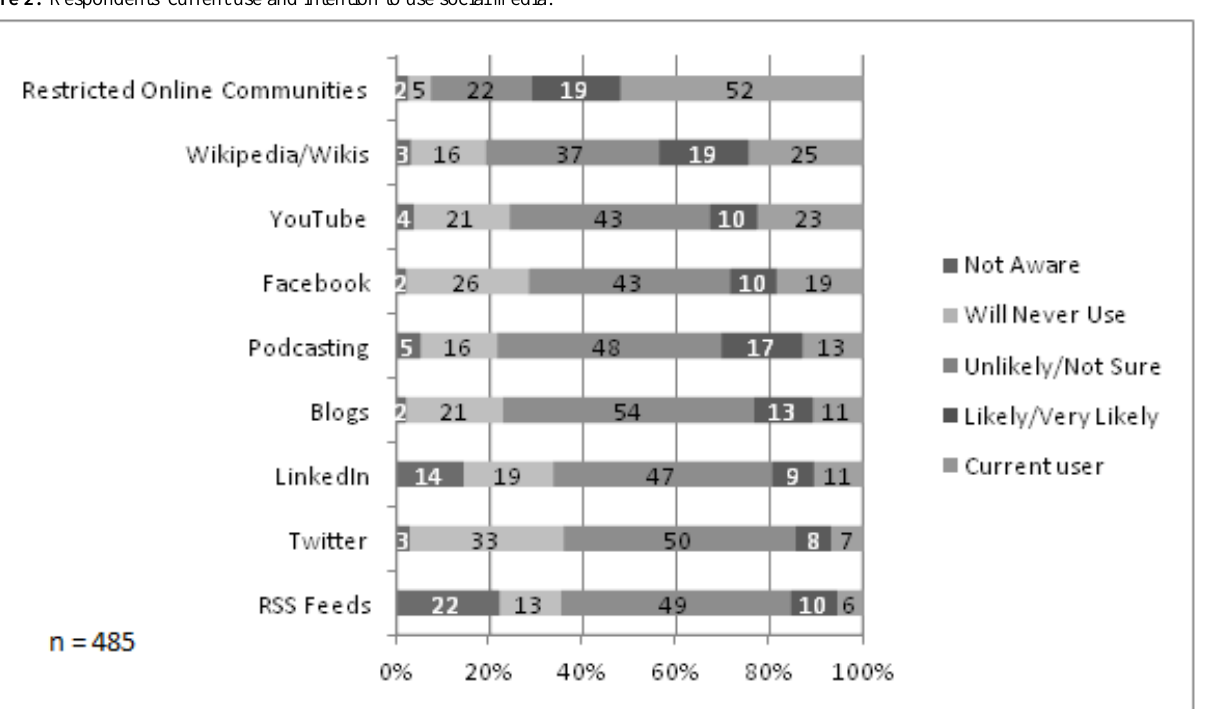
Figure 2. Respondents' current use and intention to use social